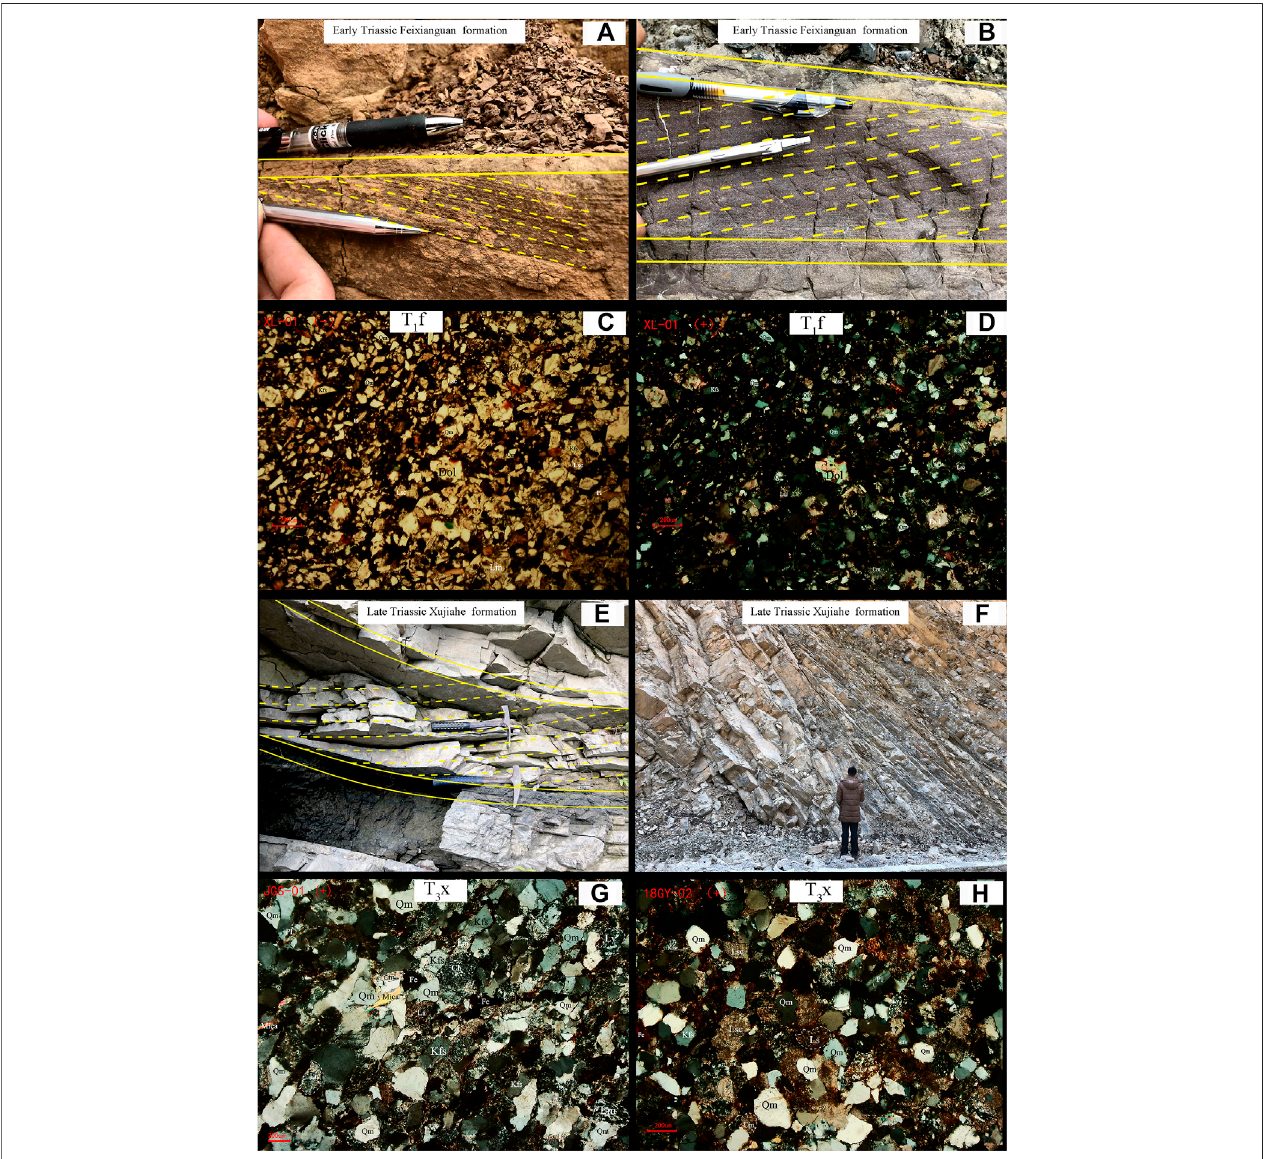
FIGURE 5 | Field photographs of typical outcrops with sedimentary structures and photo-micrographs of Lower Triassic and Upper Triassic successions in the Northwestern Sichuan Basin: (A,B) siltstone and fi ne sandstone ofLower Triassic formation with cross bedding, middle sections of NWSB; (C,D) single and orthogonal polarized light images of Lower Triassic succession, sample XL-01; (E,F) sandstone of Late Triassic formation with the cross bedding, middle section and northern sectionofNWSB; (G) orthogonalpolarizedlightimageofUpperTriassicsuccession,sampleJGS-01,middlesectionofNWSB; (H) orthogonalpolarizedlightimage of Upper Triassic succession, sample 18GY-02, northern section of NWSB. Abbreviations: Qm, monocrystalline quartz; Qp, polycrystalline quartz; Kfs, K-feldspar; Pl, plagioclase; Lv, volcanic lithic fragment; Ls, sedimentary lithic fragment; Lm, metamorphic lithic fragment; Lsc, carbonate rock; Dol, dolomite.